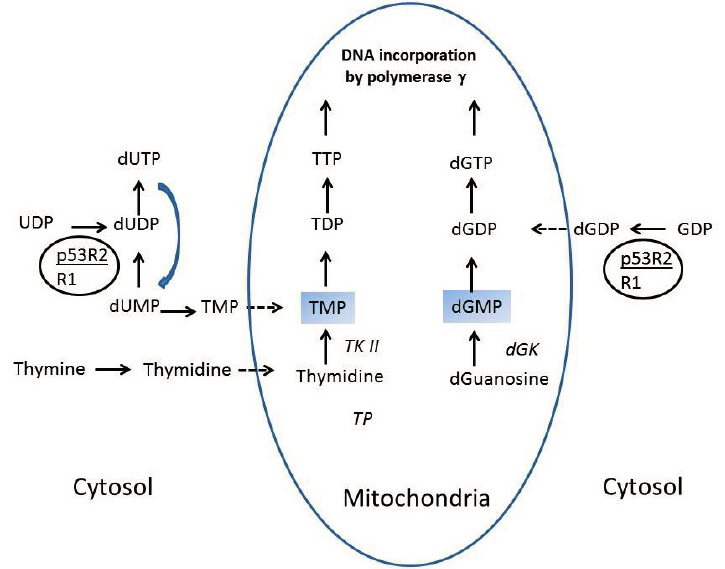
Figure 2. Key steps in the salvage of deoxynucleotides in the mitochondria. Arrows designate the steps in the salvage pathways; a dashed arrow indicates import into the mitochondria, and a blue arrow indicates degradation. The large oval (blue) is the mitochondria, the small oval (black) represents the p53-regulated ribonucleotide reductase (p53R2/R1). The nucleotides in the mitochondria include thymidylate (TMP), thymidine diphosphate (TDP), thymdine triphosphate (TTP), deoxyguanosine monophosphate (dGMP), deoxyguanosine diphosphate (dGDP), and deoxyguanosine triphosphate (dGTP). Thymidine kinase II (TK2) and deoxyguanosine kinase (dGK) are salvage